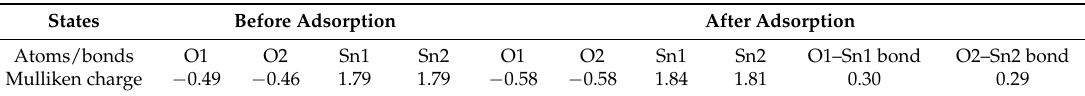
Table 7. Mulliken populations of involved atoms and bonds during the adsorption process of oleate ions on the SnO 2 (110) surface.